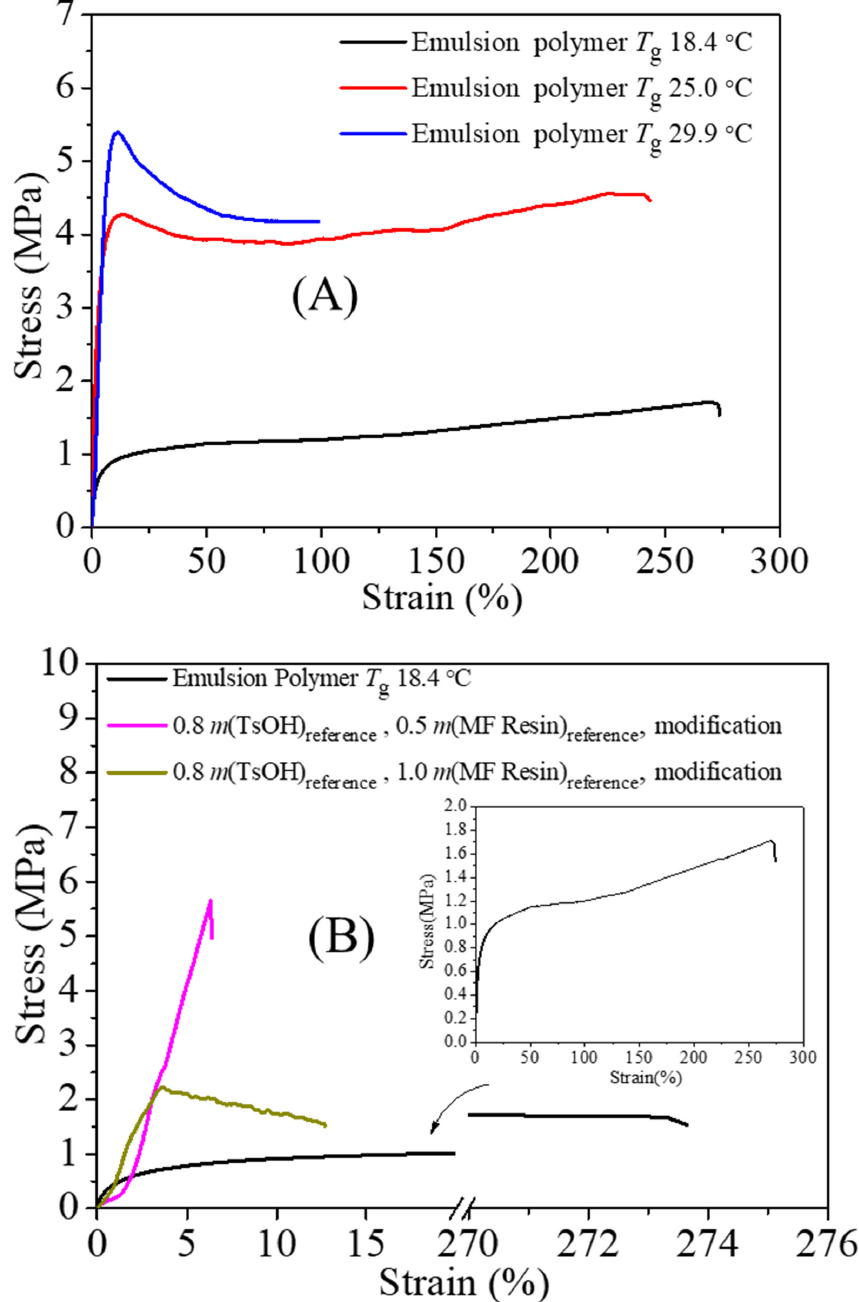
Figure 3. Stress–strain curves of ( A ) dried emulsion polymer film, and ( B ) the film modified via reaction of emulsion polymer with MF resin.